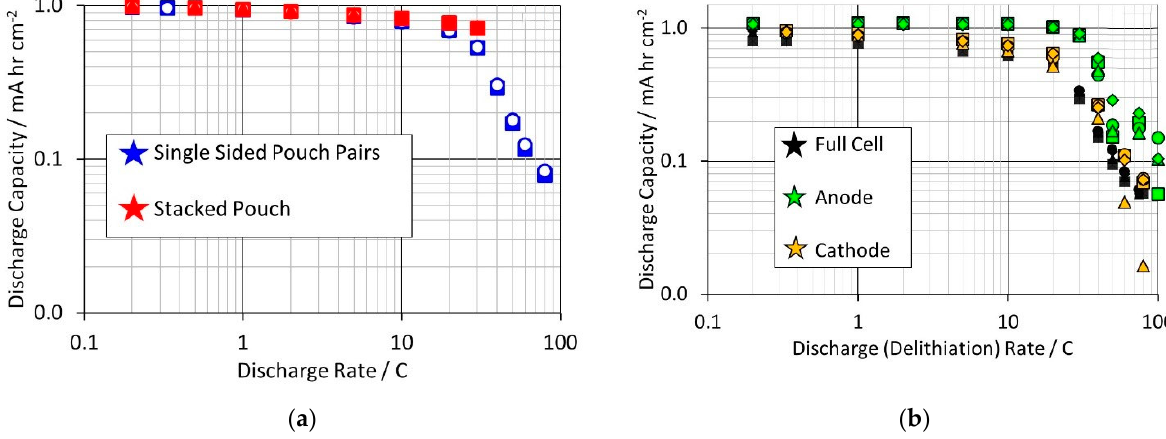
Figure 5. Discharge capacities at different rates for ( a ) single sided pair pouch and stacked pouch cells, and ( b ) coin cells.